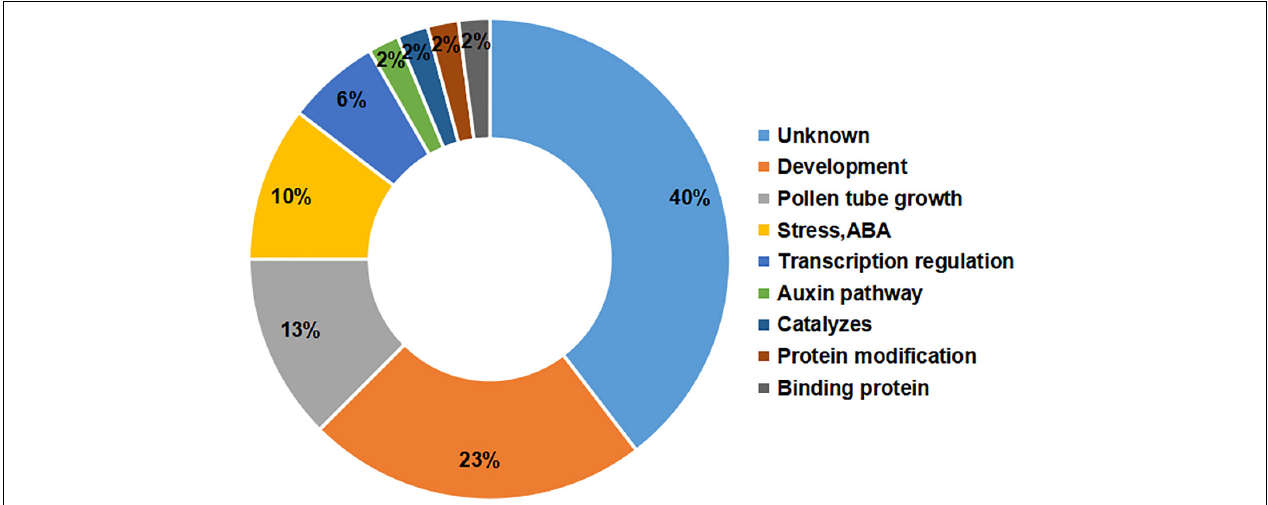
FIGURE 4 | Functional annotations of candidate genes. The number on the left represents the percentage of candidate genes. The text on the right represents the functional classification of the